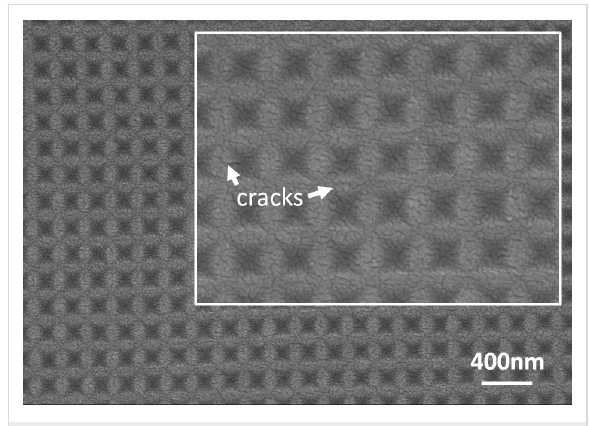
Figure 3: SEM images showing the surface topography of the ICSG resist after annealing at 550 °C for 5 h. The inset image shows small surface cracks in the resist at higher